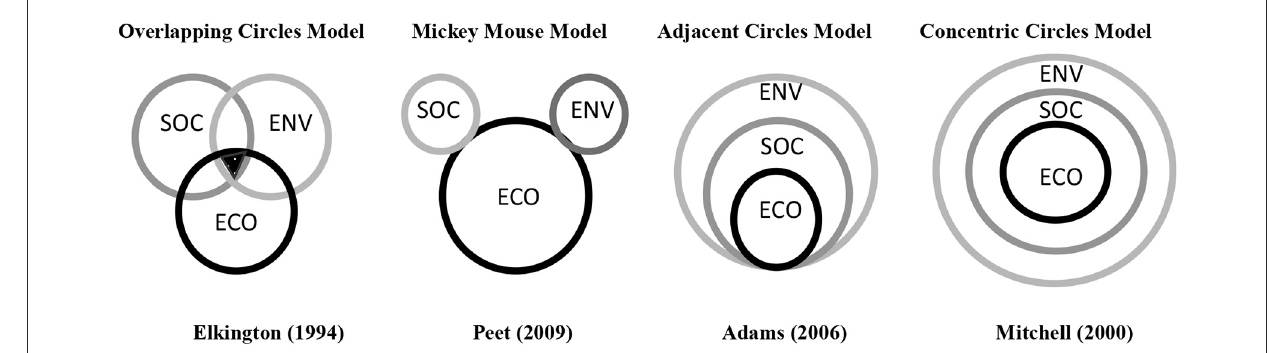
FIGURE1 Triple bottom line models. SOC, social; ENV, environmental; ECO, economic. Source: Adapted from Mulia et al. (2016).